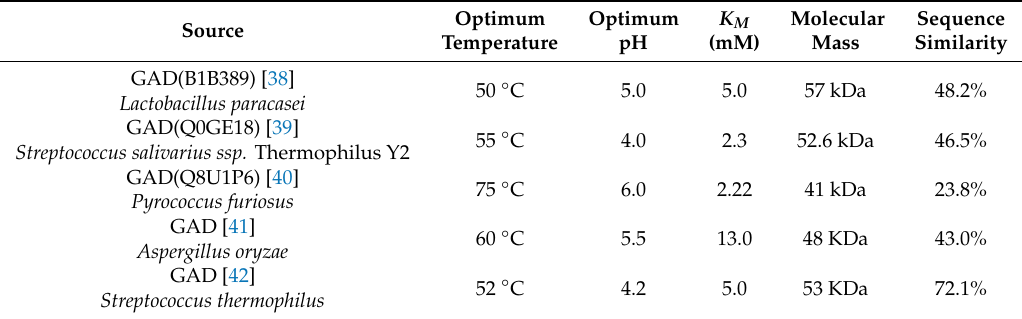
Table 3. Comparison of biochemical and kinetic properties of GADs from various